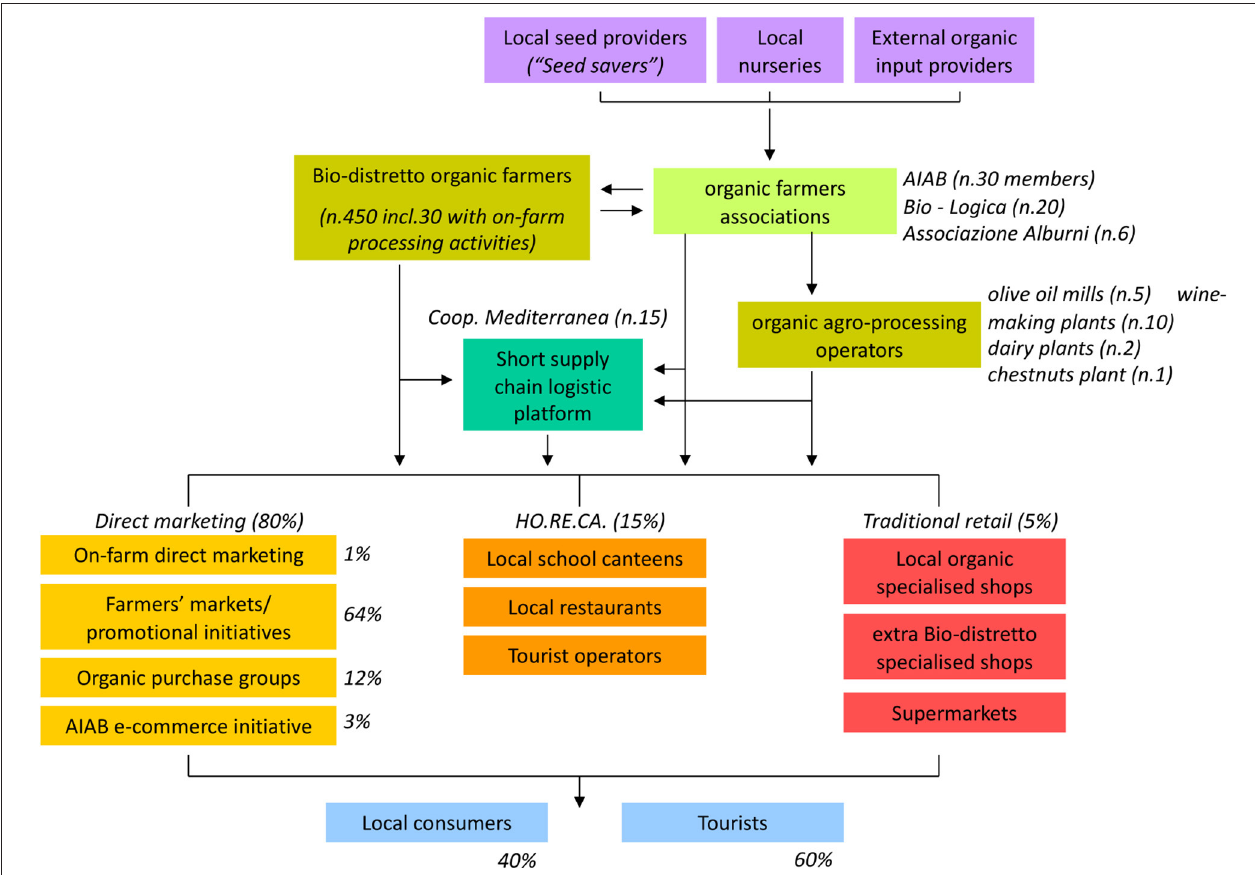
FIGURE 4 | Monitoring tool results for Cilento Eco-Region Supply chain–Module 2. Adapted from Pugliese et al. (2013) with permission from CIHEAM Bari.